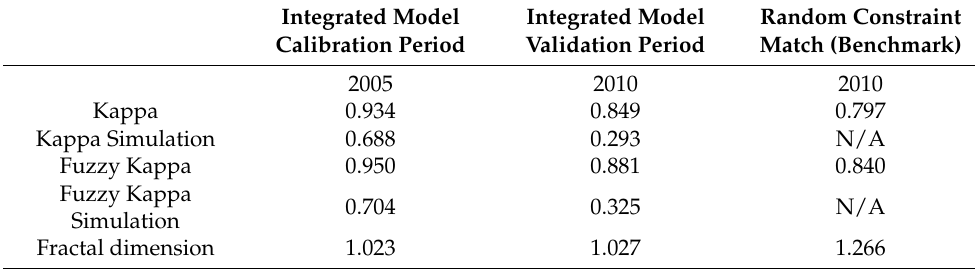
Table 5. Calibration and Validation results for the integrated land use and transport